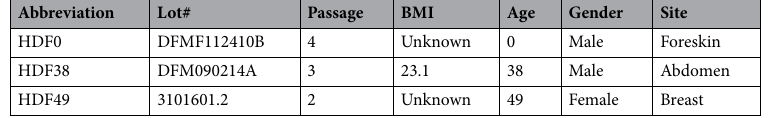
Table 1. Information on human fibroblasts used for direct